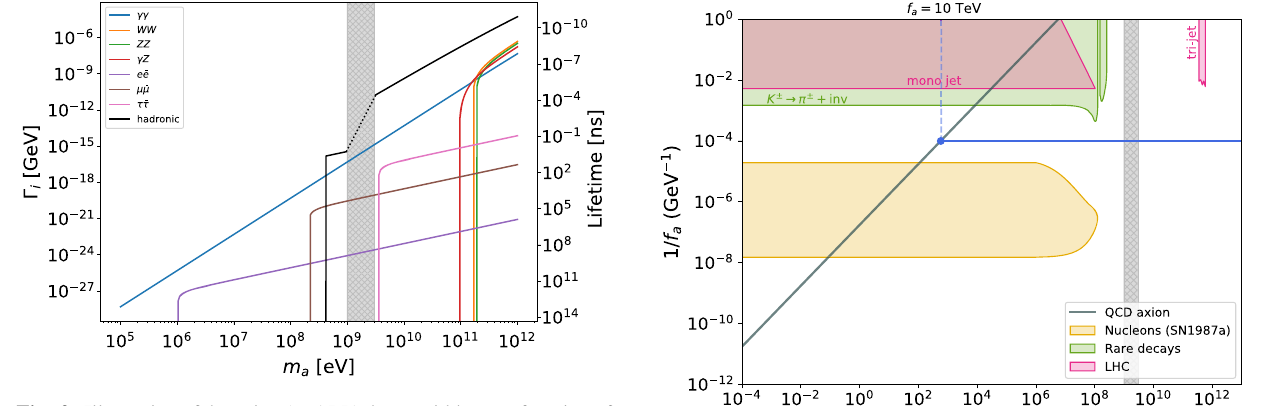
Fig. 2 Illustration of the axion (or ALP) decay widths, as a function of the axion mass for a benchmark value of g a γγ = 10 − 7 GeV − 1 and the rest of gauge boson couplings as in Eq. (4.8). The grey hatched region signals the 1–3 GeV “no human’s land” for hadronic decays in between the chiral and the perturbative regimes, where the dots indicate that no reliable prediction is possible